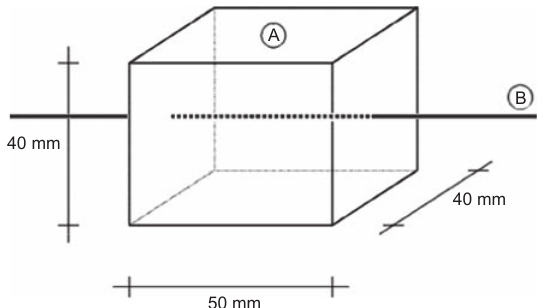
Figure 1 Schematic presentation of pull-out specimen: (A) mortar matrix; (B) fi lament yarn.